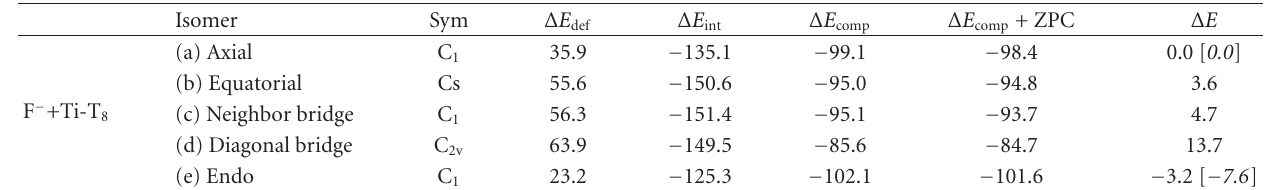
Table 6: Energy decomposition of the binding energy ( Δ E comp ) (kcal/mol) of the complexes of F − and Ti-T 8 and the energies relative to “axial” ( Δ E ) in each system based on the B3LYP/6-311+G(d)+ZPC and MP2/6-311+G(d)//B3LYP/6-311+G(d) a energies.